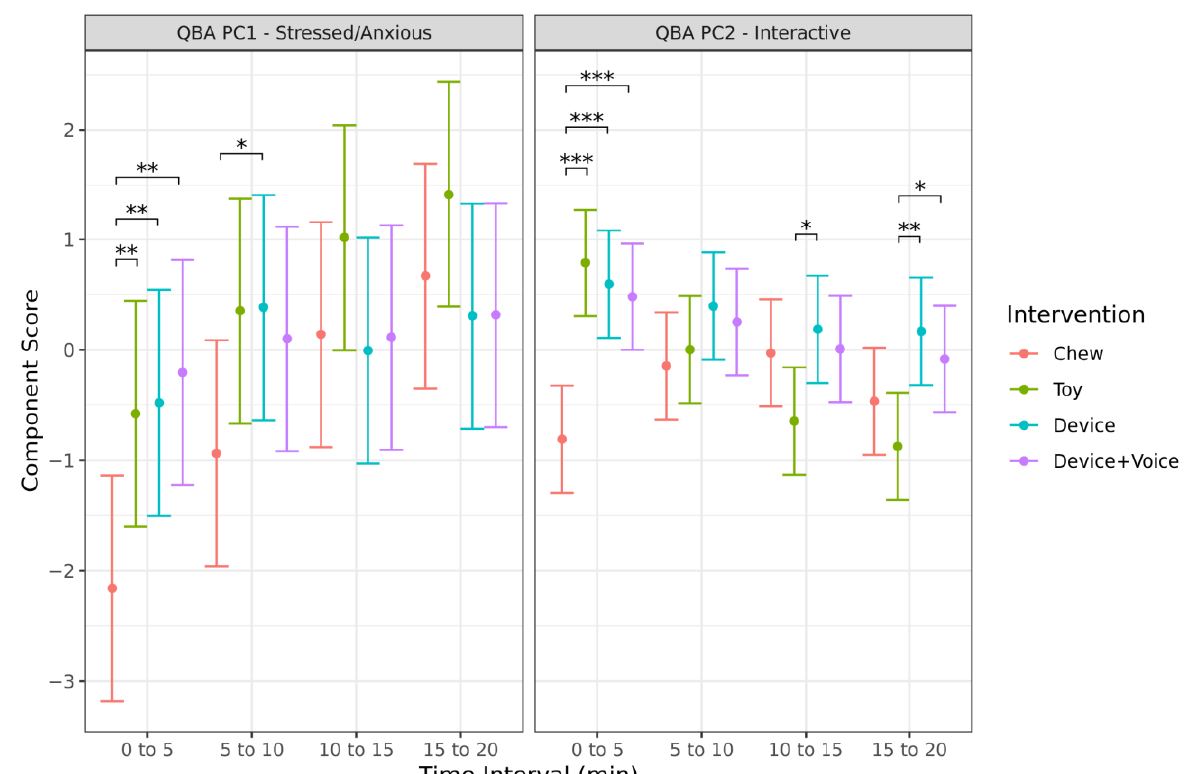
Figure 7. Predicted mean (95% CI) QBA ‘Stressed/Anxious’ and ‘Interactive’ component scores for each 5 min interval when dogs were left alone with one of four enrichments for 20 min. Asterisks indicate significant differences between treatment groups within each time interval. Three asterisks indicate significance at p < 0.001, two asterisks indicate significance at p < 0.01, and one asterisk indicates significance at p < 0.05.